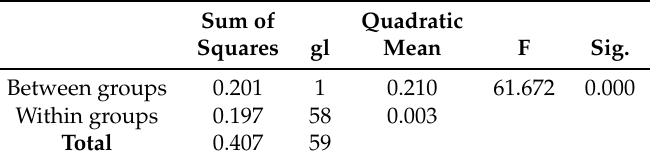
Table 7. ANOVA single factor test.